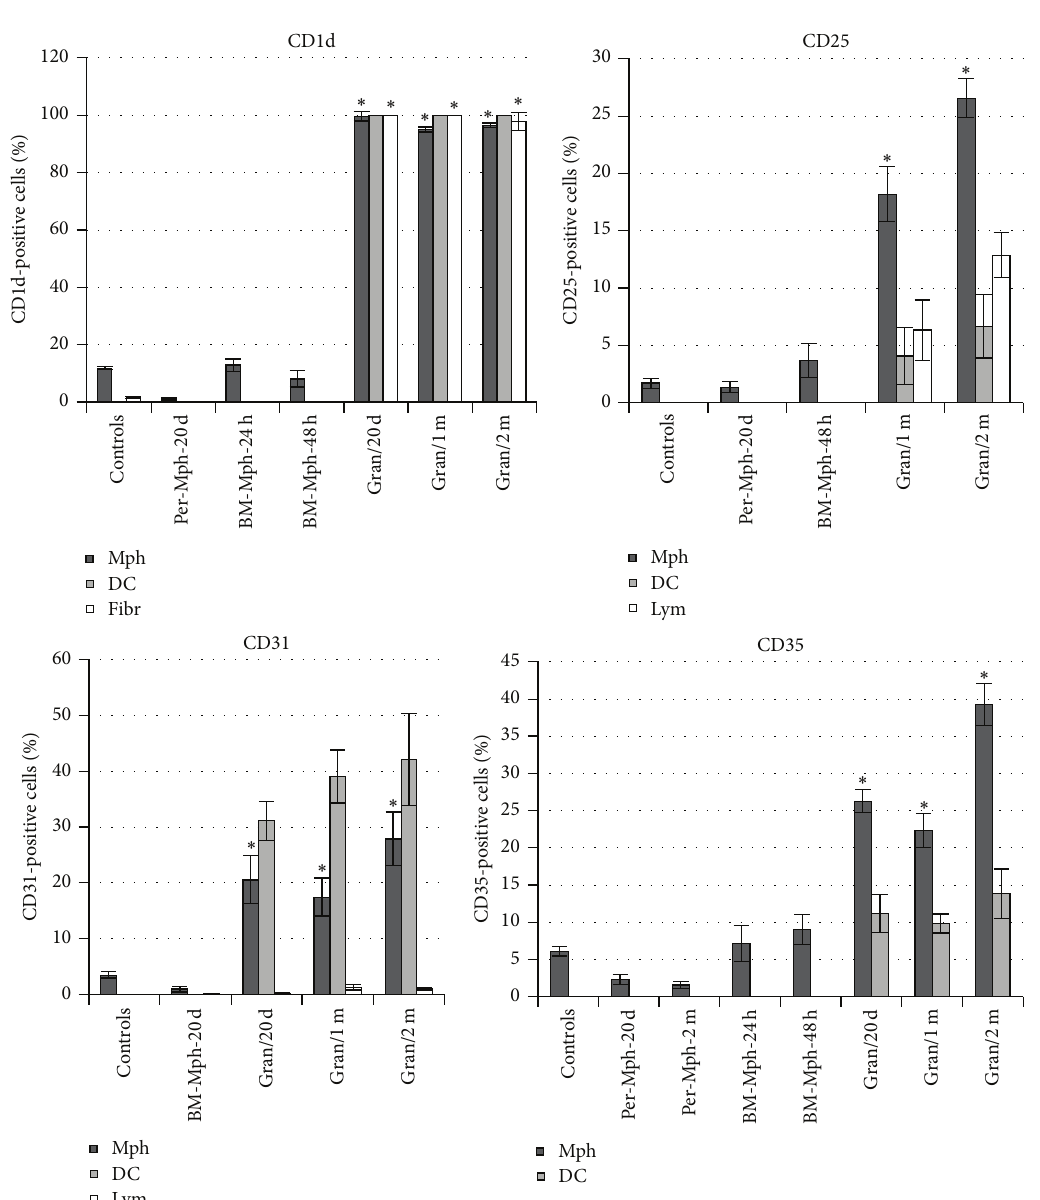
Figure 11: Macrophages (Mph), dendritic cells (DC), fibroblasts (Fibr), and lymphocytes (Lym) with cell-surface markers CD1d, CD25, CD31, and CD35. The objects examined are control peritoneal macrophages and splenic fibroblasts from three intact mice, peritoneal and bone marrow macrophages obtained from two mice on day 20 following intraperitoneal infection with the BCG vaccine (Per-Mph-20d and BM-Mph-20d, resp.), peritoneal macrophages obtained from mouse 25 after two months following intraperitoneal infection with the BCG vaccine (Per-Mph-2m), mouse bone marrow macrophages following infection with the BCG vaccine in vitro and after culture for several hours (BM-Mph-24h and BM-Mph-48h), and granulomas (Gran) from the spleens of two to four mice after 20 days (Gran/20d), one month (Gran/1m), and two months (Gran/2 m) following BCG infection in vivo and ex vivo culture for several hours. Granuloma cells producing various surface antigens were analyzed in each granuloma separately; the values were averaged for all the mice and then combined for granulomas in each group. In each experiment, more than 1000 cells were analyzed at each time point. Data are expressed as the means ± SEM. ∗ 𝑃 < 0.01 (comparisons of the number of CD-positive macrophages in each Gran group and controls, BM-Mph-24h, BM-Mph-48h, Per-Mph-20d, BM-Mph-20d, and